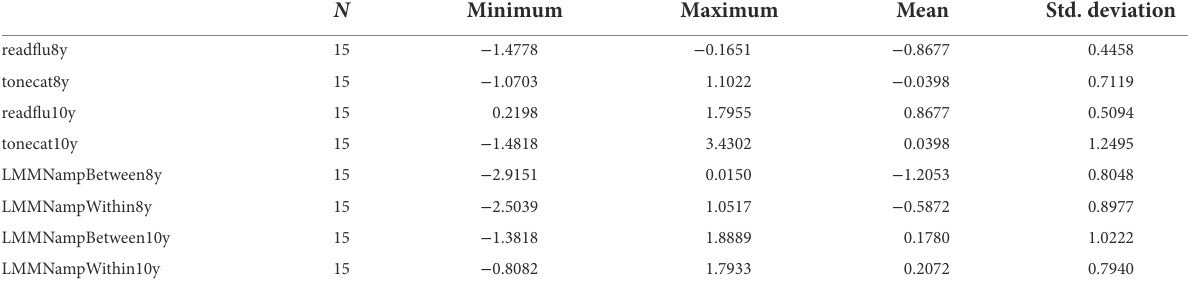
TABLE 2 Descriptive statistics for behavioral measures and